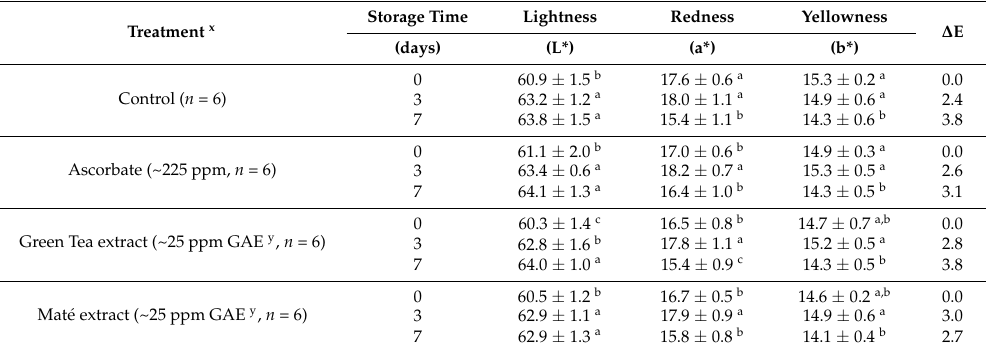
Table 2. Color parameters and the total color difference ( ∆ E) in brine-injected pork